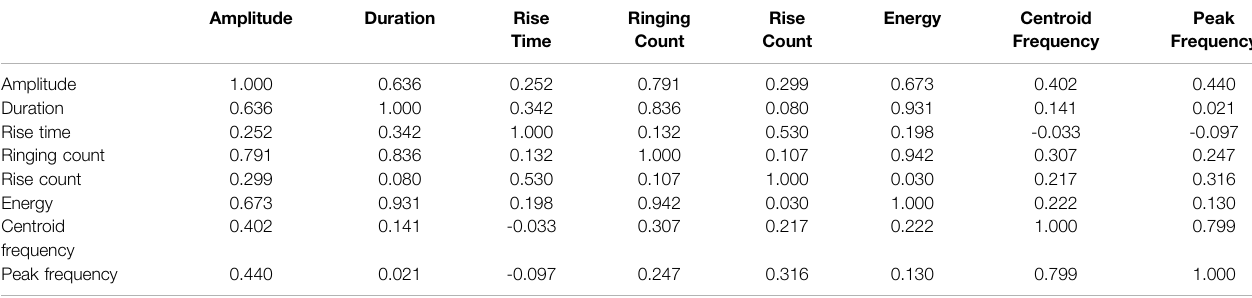
TABLE 2 | Pearson correlation coef fi cient of characteristic parameters of AE signal of sample 1.